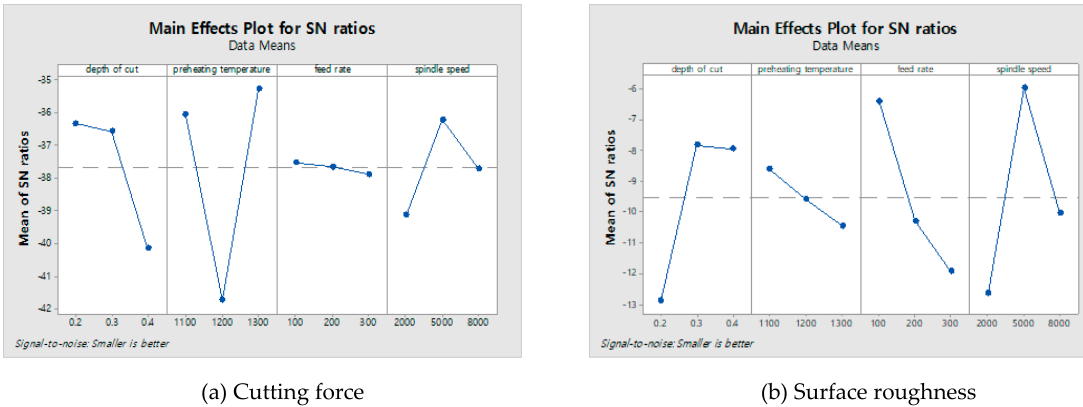
Figure 8. The main effect plot of C/SiC composite on the cutting force and the surface roughness. ( a ) Cutting force; ( b ) Surface roughness. Table 7. The response table mean signal to noise (S/N) ratio for the cutting force according to the machining conditions.